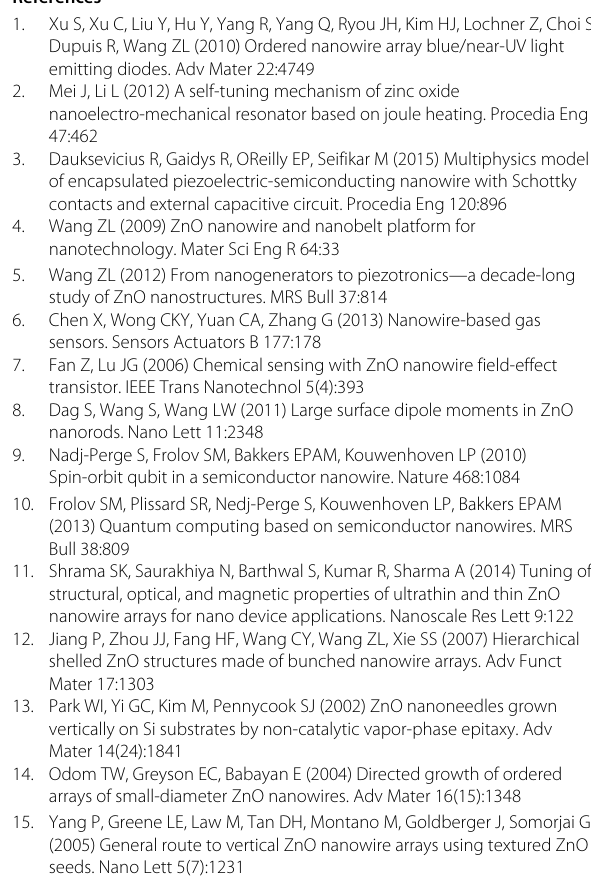
Additional file1: Figure S1. Scanning electron microscope images of the nanostructures for Al-doped ZnO seed layers for all used temperatures and concentrations. (PDF 1249 kb) Additional file2: Figure S2. Scanning electron microscope images of the nanostructures for Ga-doped ZnO seed layers for all used temperatures and concentrations. (PDF 1105